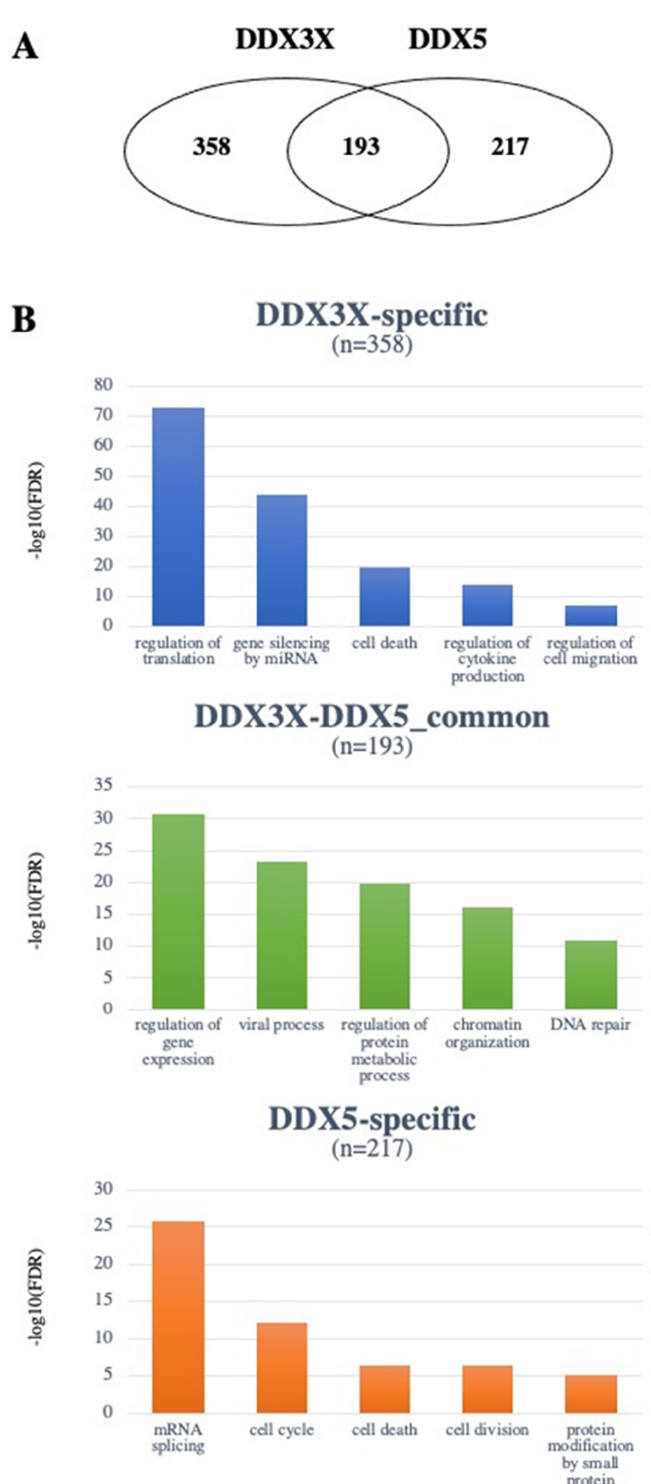
Figure 2. The DDX3X and DDX5 interactomes. ( A ) Venn diagram showing the number of non- redundant common or unique interactors of DDX3X and DDX5. ( B ) GO classification of the most represented functional classes among either common or unique interactors of DDX3X and DDX5. Different y -axis scales reflect the different frequencies in the